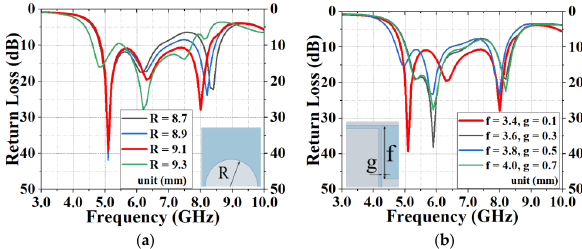
Figure 8. Improvement of the return loss by optimizing ( a ) the radius, R, of the back circle of the antenna and ( b ) the length, f, and width, g, of the parasitic strip.